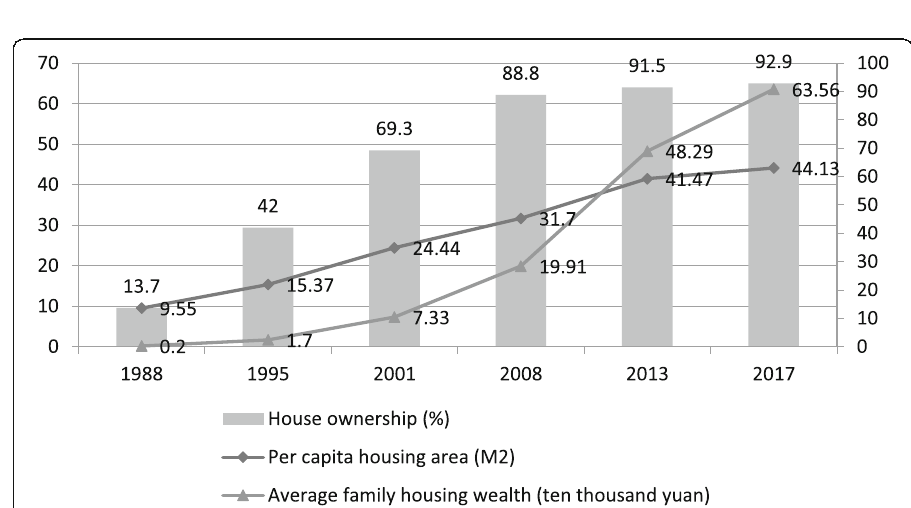
Fig. 1 Changes in homeownership, per capita housing area, and housing wealth (1988 – 2017). Note: The data of 1988 and 1995 are from the Chinese Household Income Project (CHIP); the data of 2001 are from the Research of China Social Structure (RCS), and the data of 2008, 2013, and 2017 are from the Chinese Social Survey